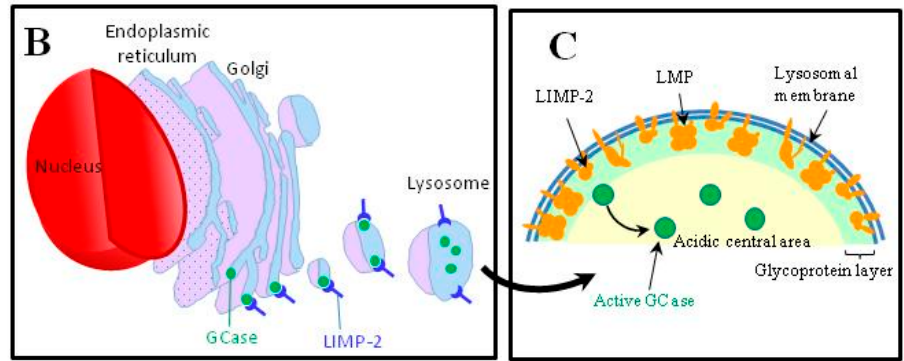
Figure 2. Alternative metabolic pathway of the glucosylceramide (GlcCer) accumulation due to the glucocerebrosidase (GCase) deficiency. The expression of GCase varies from one cell type to another and depends on the tissue. ( A ) In a mouse model of GCase deficiency (red cross), GlcCer is transformed via an alternative ceramidase pathway into glucosylsphingosine (red arrow), which is degraded by cytoplasmic GCase2 ( GBA2 gene), active at a neutral pH, to S1P, a very active metabolite [20]. ( B ) Protein maturation takes place in the Golgi apparatus; the transport and delivery of GCase to lysosomes require a particular molecule, LIMP-2, which allows GCase to reach the lysosome where the acidic pH breaks the molecular link [39]. ( C ) LIMP-2 is a lysosomal membrane protein (LMP) whose highly glycosylated intra-lysosomal part protects the lysosome’s membrane. LIMP-2 anomalies can induce a phenotype rather than GD3 [39].